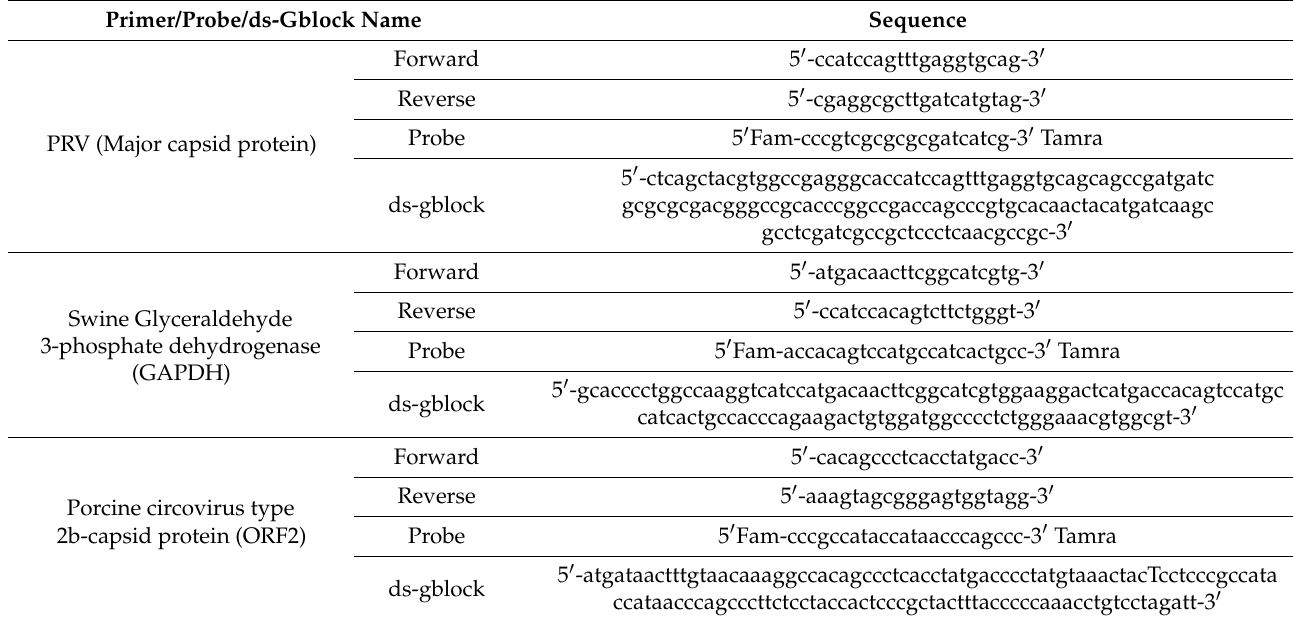
Table 3. List of primers, probes, and double standard gene blocks (ds-gblock as standard) used in quantitative PCR used for quantification of pseudorabies (PRV)/porcine circovirus type 2b (PCV2b) genome in samples and subsequent normalization based on glyceraldehyde 3-phosphate dehydroge- nase (GAPDH) housekeeping